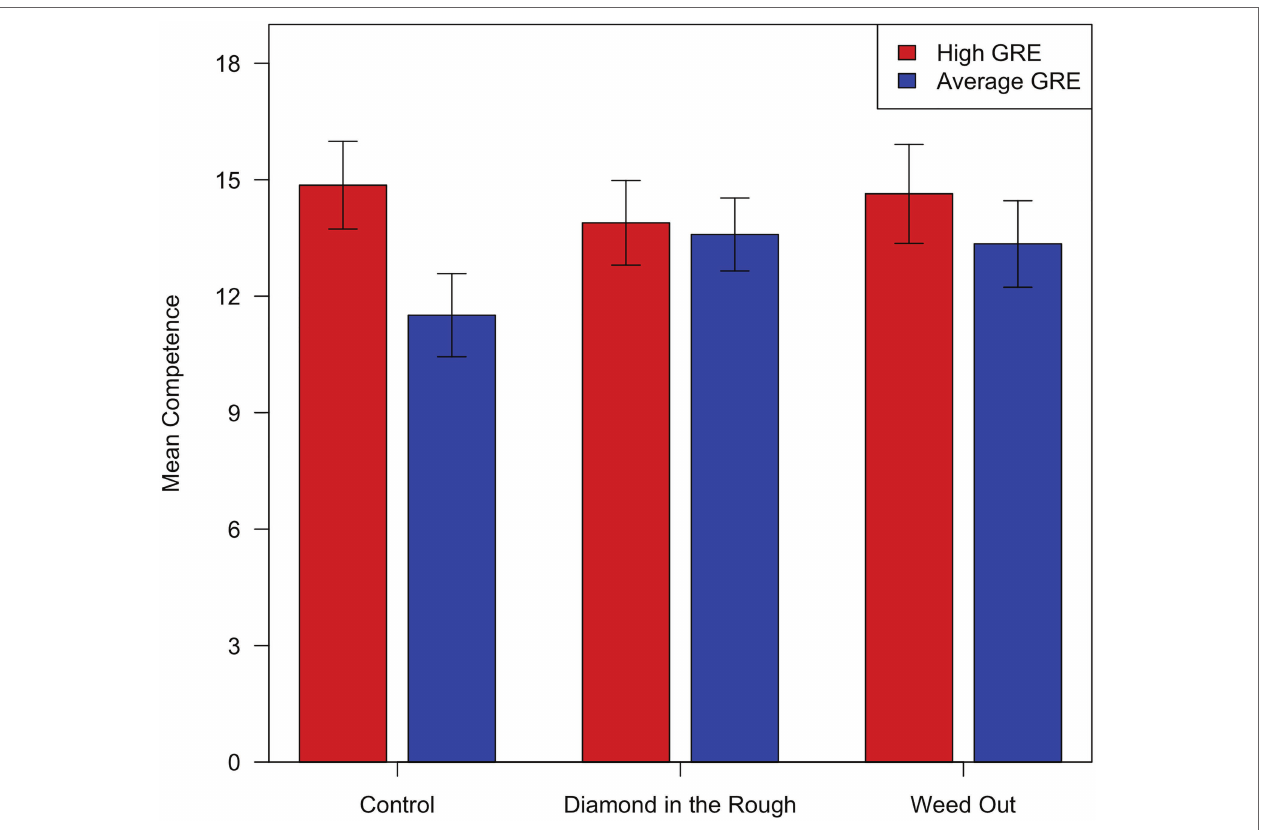
FIGURE 1 | Mean competence scores as a function of vignette and instructional set. Error bars show 95% confidence